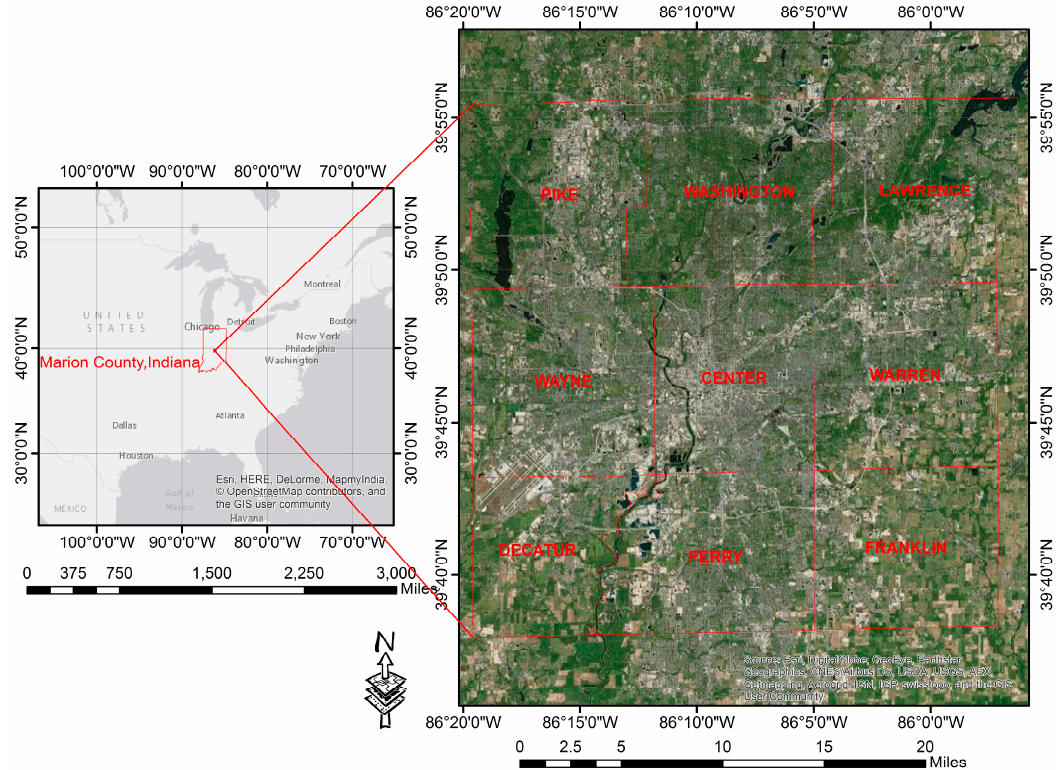
Figure 1. The location of the study area, Marion County, Indiana, USA, and the nine townships in Marion County.